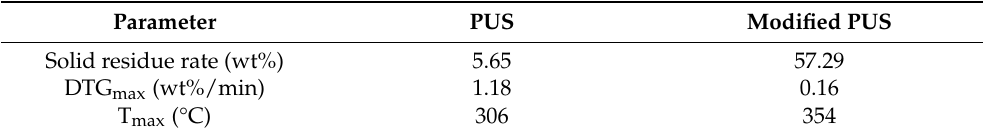
Figure 6. ( a ) The thermal gravity (TG) and ( b ) differential thermal gravity (DTG) curves of PUS before and after modified PUS. before and after modified PUS. Table 3. The thermal weight data of the sample. Table 3. The thermal weight data of the